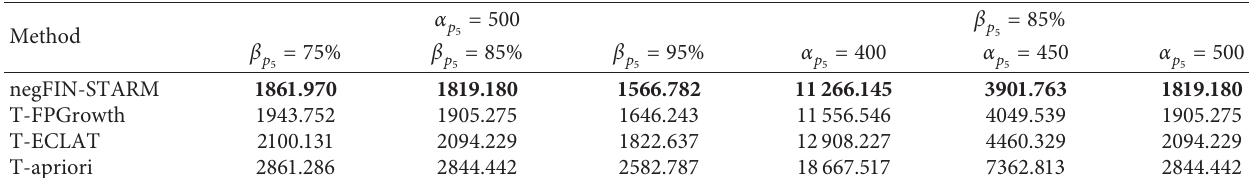
Table 7: Execution time (ms) of four methods on the chess data set when Q � p